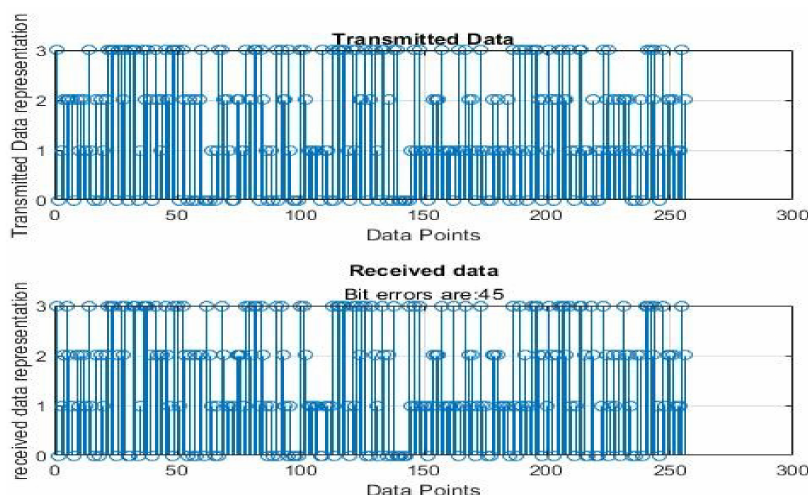
Figure 13. Customary QPSK output for 256 data points in a noisy channel.